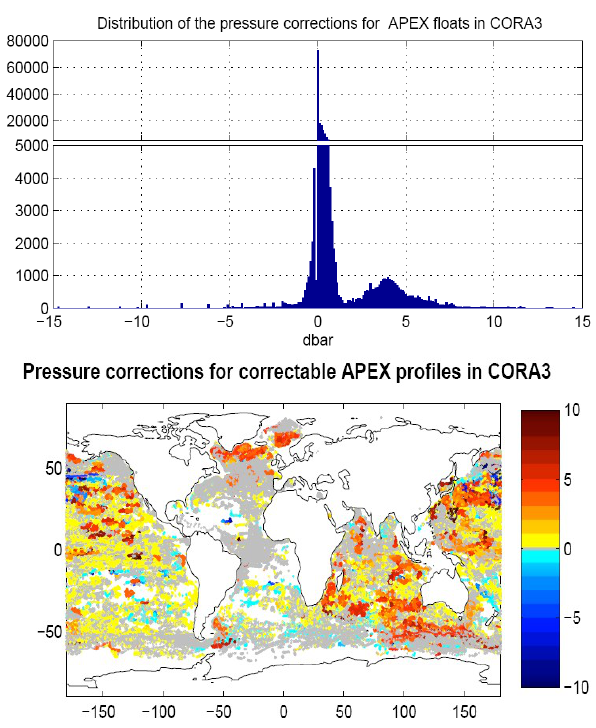
Fig. 12. (Top) Distribution of the pressure corrections for APEX float profiles that are adjusted (either in delayed mode or in real time) in CORA3 and (bottom) geographical distribution of these corrections (in dbar). Most of the corrections are for positive bias of the pressure sensor as cases of negative bias are truncated to zero for Apf-8 and earlier versions of controller. Negative bias started to be correctable with the Apf-9